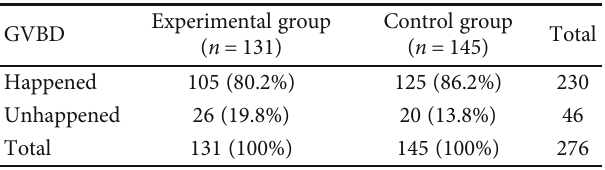
Table 2: Comparison of polar body discharge between the experimental group and the control group. Polar body Experimental group discharge